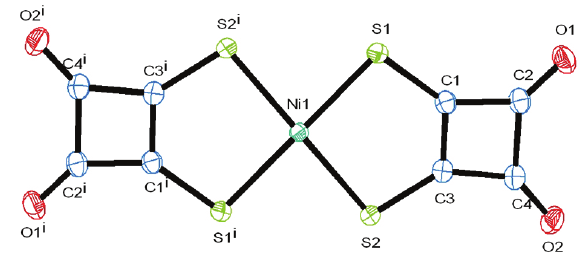
Figure 1. ORTEP plot of the complex dianion in bis(n-hexyltrip- henylammonium)-bis(1,2-dithiosquarato)nickelate(II), (HexPh ] . 2